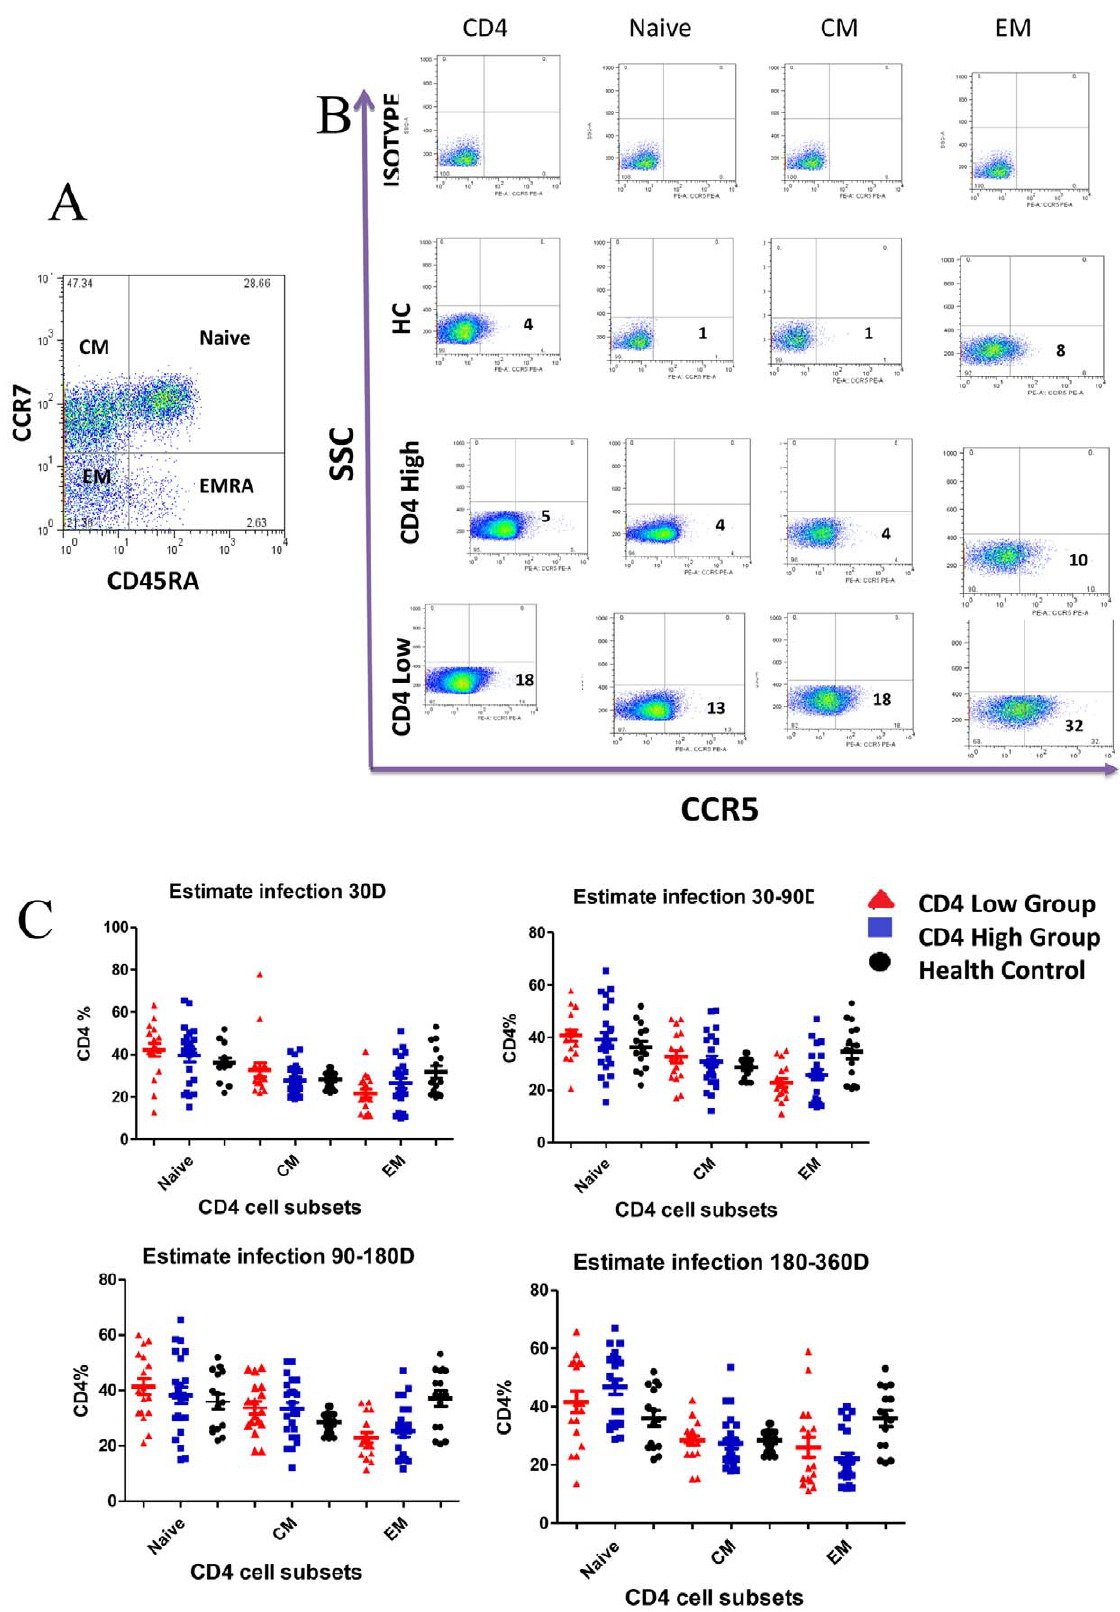
Figure 1. Comparison ofthe percentage of CD4 subsets between the CD4 Highand CD4 Low groups. (A)Based on the expression of CD45RA and CCR7, CD4 T cells were subdivided into naive(CD45RA + CCR7 + ), central memory(CM; CD45RA–CCR7 + ) and effect memory (EM; CD45RA–CCR7–) cell subsets. (B–C)Comparison of the percentage of CD4 subsets between the CD4 High and CD4 Low groups during the first year of HIV infection. doi:10.1371/journal.pone.0049526.g001 PLOS ONE |